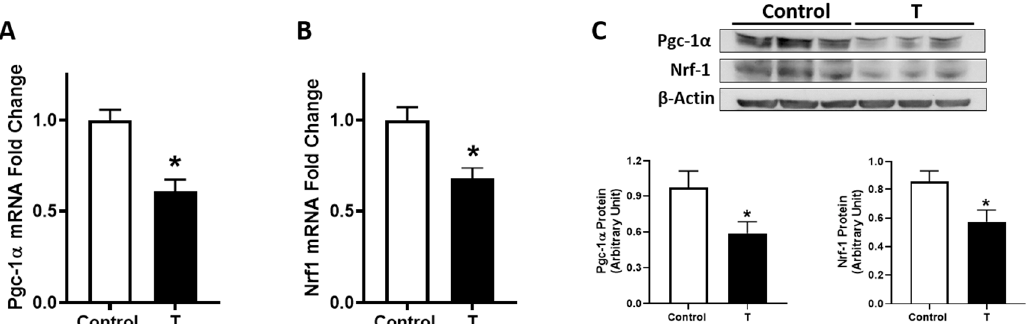
Figure 4. Expression of mitochondrial biogenesis indicators in the placenta of control and T-treated pregnant rats. Real-time PCR was used to assess ( A ) Pgc-1a and ( B ) Nrf1 mRNA expression in the placenta. Quantitation of placental Pgc-1a and Nrf1 mRNA expression was normalized relative to β -actin. ( C ) Representative Western blots for Pgc-1 α , Nrf1, and β -actin are shown at top; blot density obtained from densitometric scanning of Pgc-1 α and Nrf1 normalized to β -actin is shown at the bottom. Data presented as means ± SEM of 6 rats in each group. * p < 0.05 vs. control.